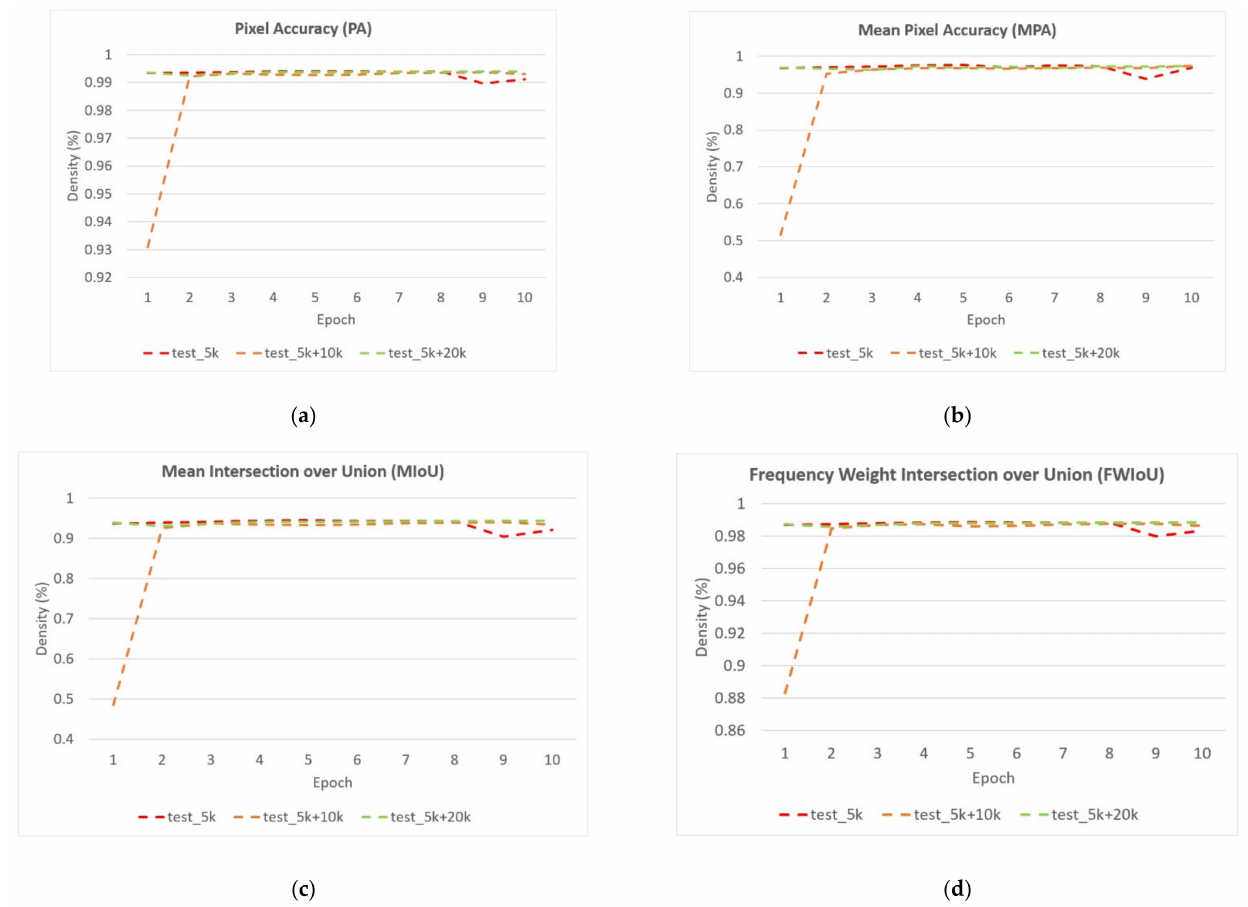
Figure 19. The performance of Deeplab network on customized dataset based on the value of: ( a ) Pixel Accuracy (PA); ( b ) Mean Pixel Accuracy (MPA); ( c ) Mean Intersection over Union (MIoU); ( d ) Frequency Weight IoU